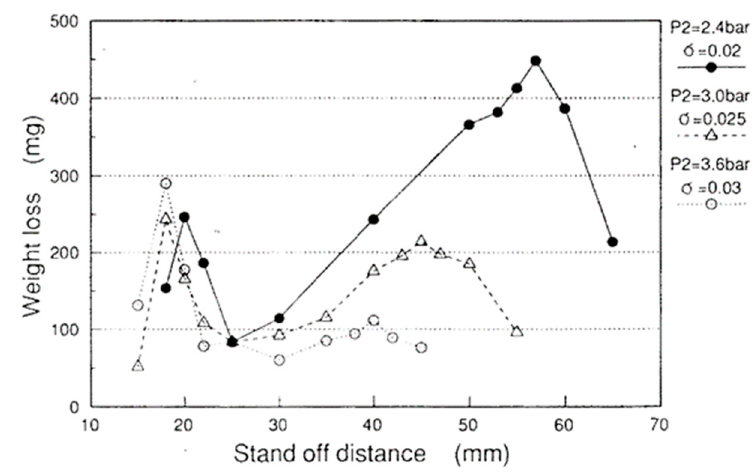
Figure 12. Weight loss, i.e., the aggressive intensity of the jet, as a function of standoff distance changing with cavitation number at constant injection pressure. The peak at the near side of the nozzle, i.e., the 1st peak, was caused by water column impacts. The peak at the far side from the nozzle, i.e., the 2nd peak, was produced by cavitation impacts. The standoff distance of 2nd peak was changed by the cavitation number [77].